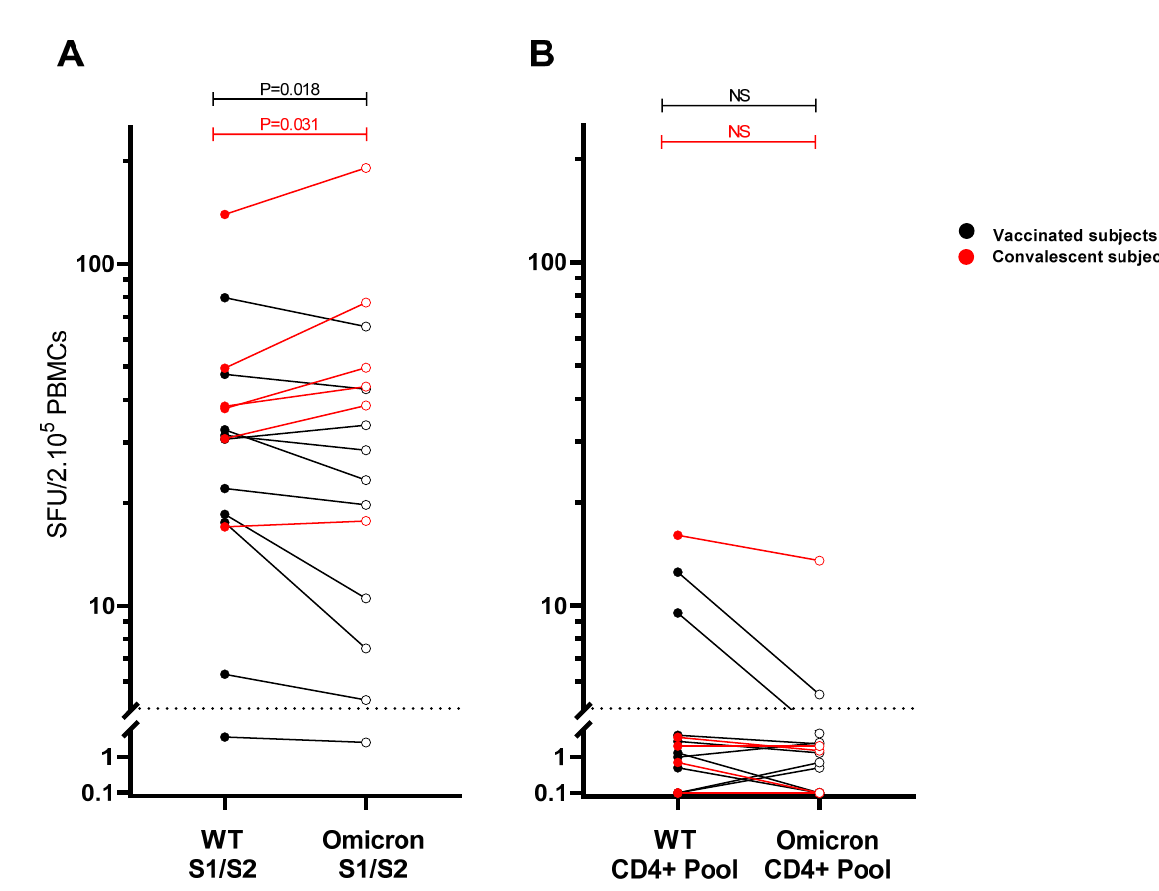
Figure 2. Ex vivo T-cell responses against Omicron BA.1 whole spike protein are relatively pre- served in most prior-vaccinated and convalescent individuals. The SARS-CoV-2-specific IFN- È + T-cell response was measured by ELISPOT assay. PBMCs of vaccinated ( n = 10; black dots/lines) and convalescent individuals ( n = 6; red dots/lines) were directly stimulated with ( A ) a pool of overlapping peptides for the entire spike protein (S1 + S2) corresponding to the D614G wild-type (WT) strain versus the Omicron BA.1 variant or with ( B ) a pool of selected CD4 + T-cell epitope candidates from WT strain versus the corresponding sequences of the Omicron BA.1 variant. Each pair of dots connected with line represents SARS-CoV-2-specific IFN- È + T-cell response of one subject responding to WT (closed dots) versus Omicron BA.1 peptides (open dots). Dotted line indicates threshold for IFN- È -positive responses. Pairwise comparison of T-cell responses to WT and Omicron BA.1 peptide pools assessed by Wilcoxon signed-rank T test revealed a significant difference in response in vaccinees (reduction in response to overlapping S1/S2 Omicron peptide pool; p = 0.018) and convalescent subjects (increased response to S1/S2 Omicron peptide pool; p = 0.031). SFU—spot forming units.